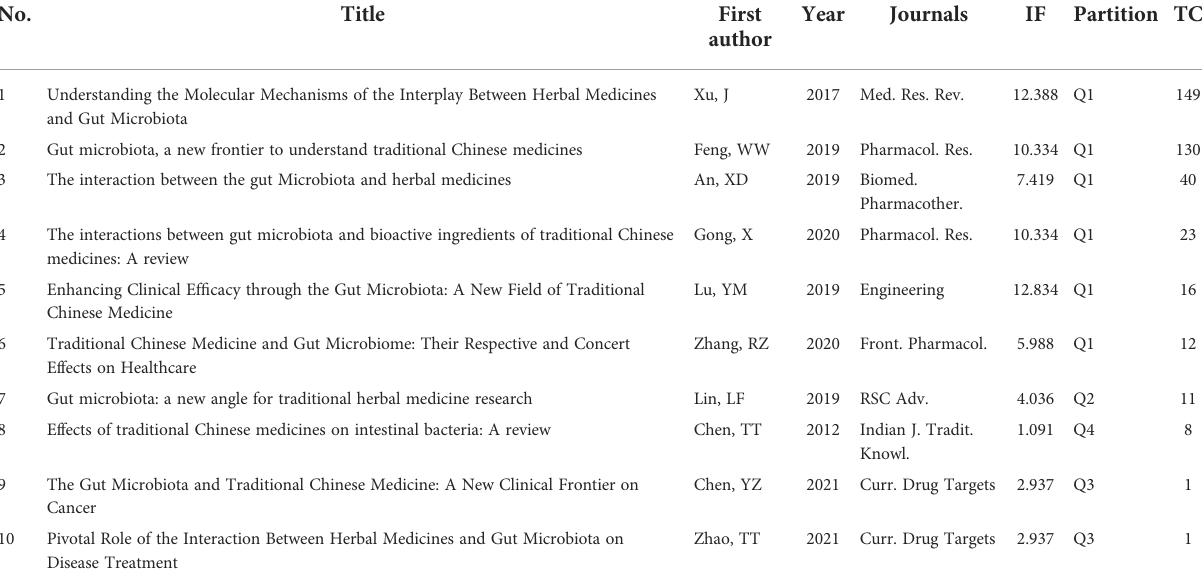
TABLE 7 The review articles on mechanism of interactions between TCM and GM.